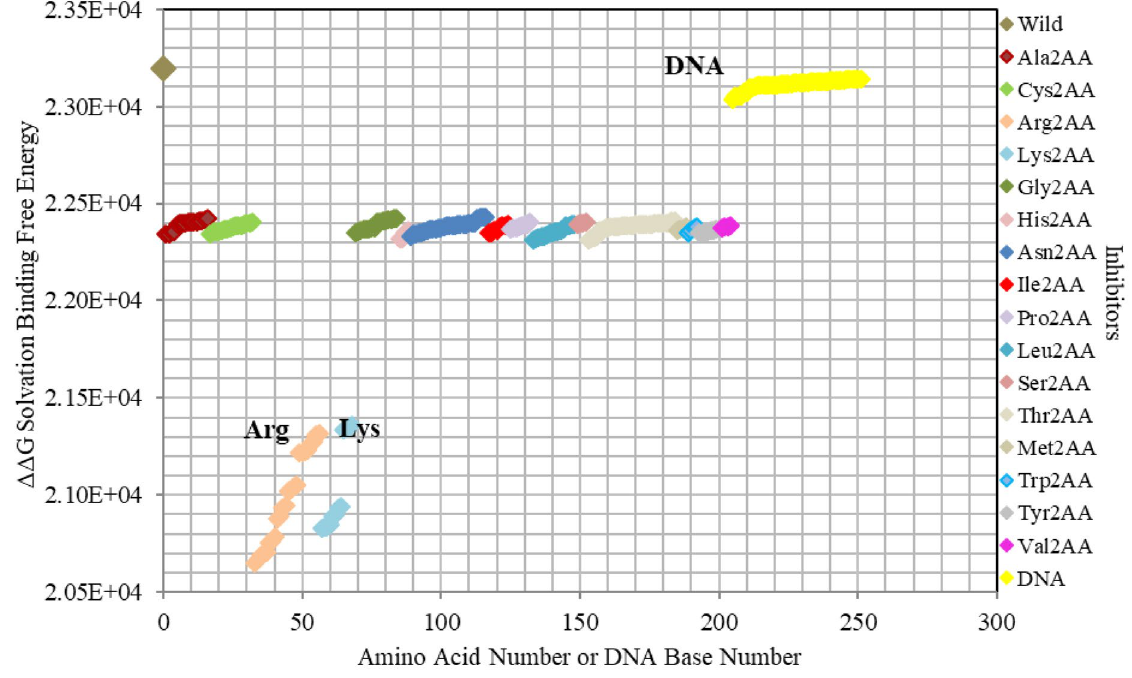
Figure 11. Electrostatic free energy differences of all GATA3 inhibitors within GATA3:DNA complex. Plot presents the solvated binding free energy calculations (in KJ/mol) of all GATA3 amino acid mutants that are inhibitors in both of Chain-C and Chain-D, and that is in comparison with those of the DNA sequence bases in order to elucidate their relative effect on binding.